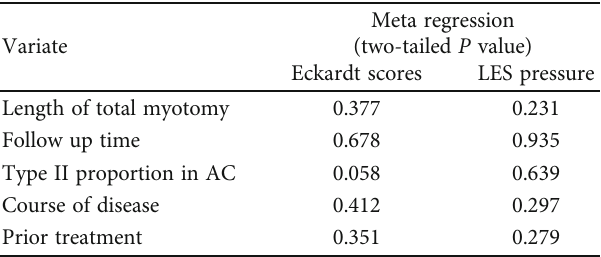
Figure 2: (a) Forest plot, di ff erence in pre- and postoperative LES pressure before balancing baseline; (b) Forest plot, pre- and postoperative LES pressure di ff erence between anterior and posterior approaches after balancing baseline Labels 1 and 2 were sectionalizations inside the study. They grouped these factors as follows: preoperative intervention/non-preoperative intervention (Tang, 2017), FTM/CM (Duan, 2017), Chagas/idiopathic (Farias, 2020), and anterior/posterior (Ramchandani, 2018; Tan, 2018). Table 2: Metaregression with di ff erences in pre- and postoperative Eckardt scores/LES